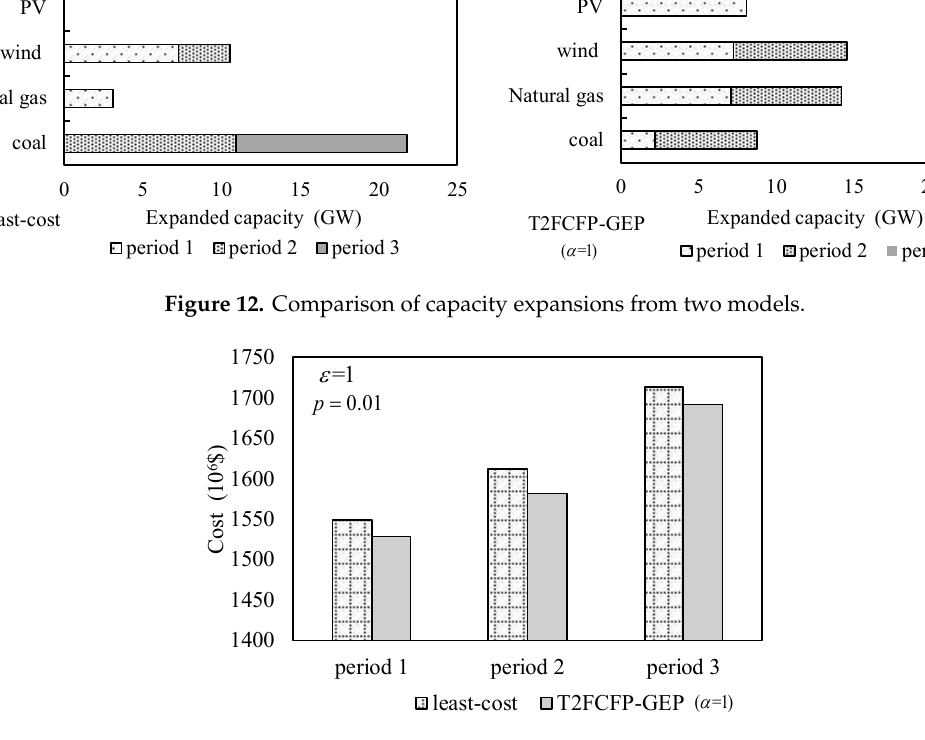
Figure 13. Comparison of total cost for pollutant treatment and pollutant emission from two models.